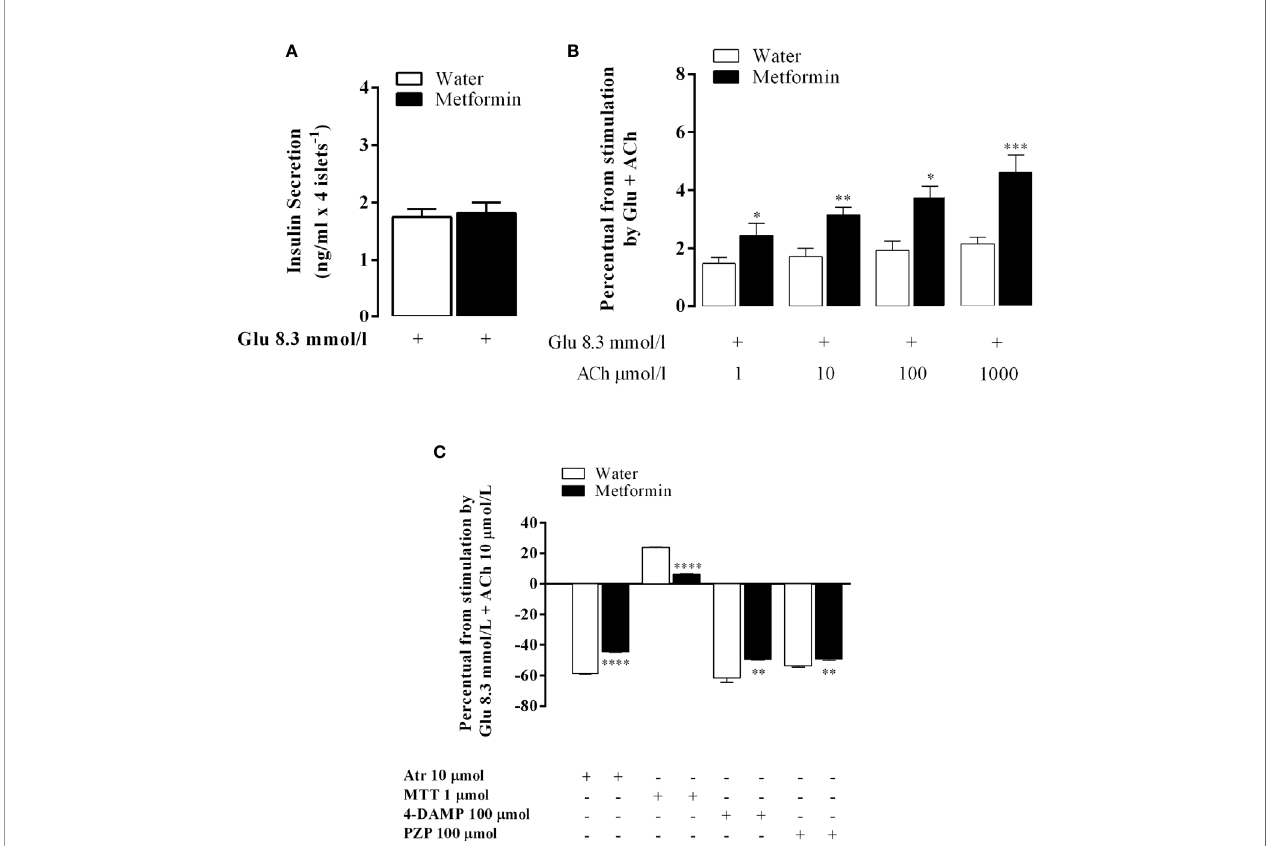
FIGURE 3 | The in vitro effect of the muscarinic receptor agonist and antagonists on GIIS. Bars represent the mean ± SEM of insulin secretion from the pancreatic islets of eight rats that were obtained from four different litters. (A) Insulin secretion that was stimulated by 8.3 mmol l − 1 Glu and potentiated by 10 mmol l − 1 ACh. (B) The percentage of insulin release stimulated by 8.3 mmol l − 1 Glu and 8.3 mmol l − 1 Glu potentiated by 1, 10, 100 and 1,000 mmol l − 1 ACh. (C) The bars above the 0 line representing (100% of 8.3 mmol 1 − 1 Glu-mediated insulin secretion throughout the 60 min of incubation in both groups islets) represent the percentage of the 10 m mol 1 − 1 Ach-mediated insulinotropic action. The line from 0 represents 100% of the 10 m mol 1 − 1 Ach-potentiated glucose-induced insulin release in both groups. The bars above or below the 0 line represent the agonist-provoked percentage increase or decrease [ m mol/l: a nonselective antagonist (Atr, 10) or a selective M2mAChR (MTT, 1) or M3mAChR (4-DAMP, 100) antagonist) or (PZP, 100) in 10 m mol/l Ach-potentiated glucose-induced insulin release in both groups. *p<0.01, **p<0.002, ***p<0.0005, ****p<0.0001 indicated a signi fi cant difference between groups based on Student ’ s